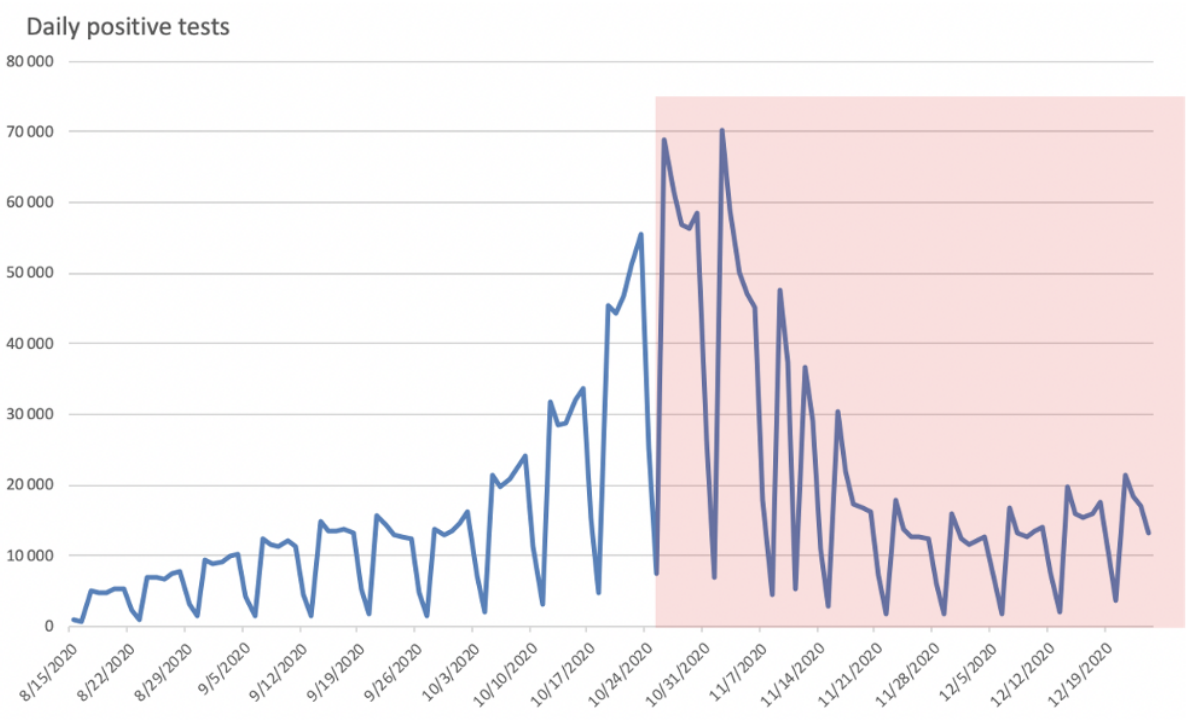
Figure 1. Impact of the partial lockdown on daily reverse transcription polymerase chain reaction positive tests. Red area: national partial lockdown